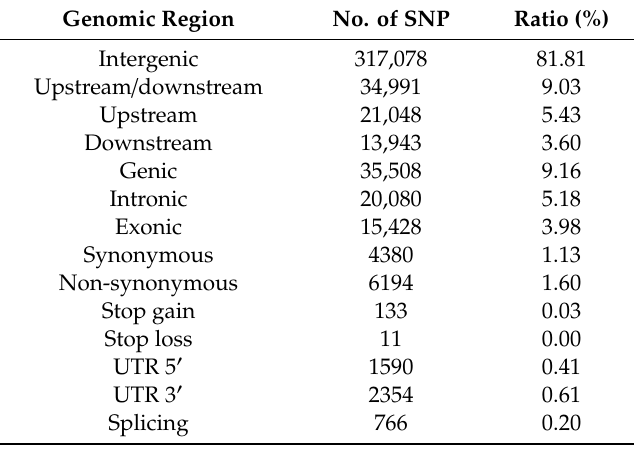
Table 2. EMS-induced SNP annotation summary of yellow leaf mutant